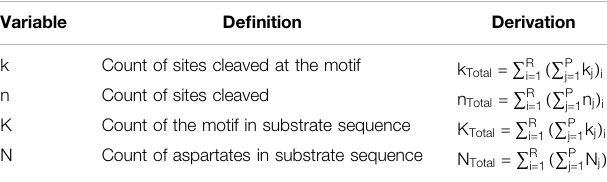
TABLE 1 | De fi nition and derivation of variables used in hypergeometric tests for each P4-P2 motif in caspase consensus